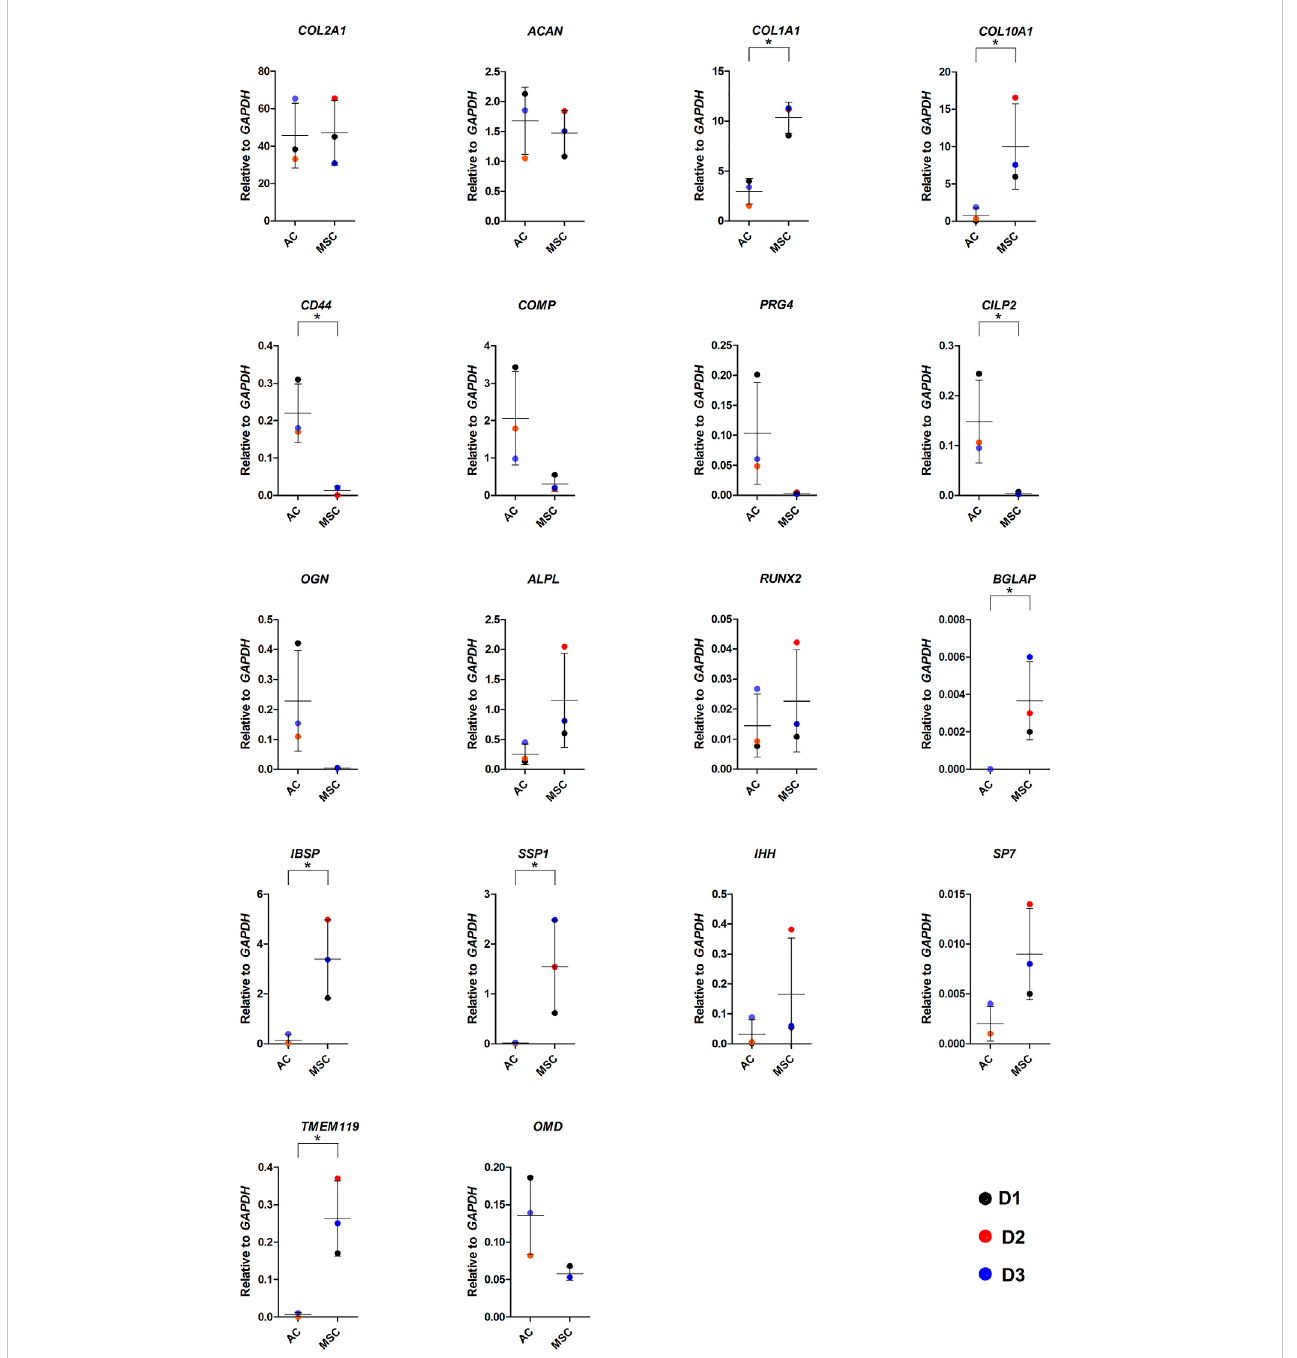
FIGURE 4 GeneexpressioninACandMSCdiscs.Real-timeRT-qPCRanalysisofcartilagediscsafter4 weeksofdifferentiationshowingcartilage-andhypertrophy/ ossi fi cation-related markers. Data presented as dot plot diagram with mean and SD; D1-D3 (donor 1 – 3). Student ’ s t -test was used for statistics, and p ≤ 0.05 was considered signi fi cant. N = 3 for each experimental group and DF = 4.